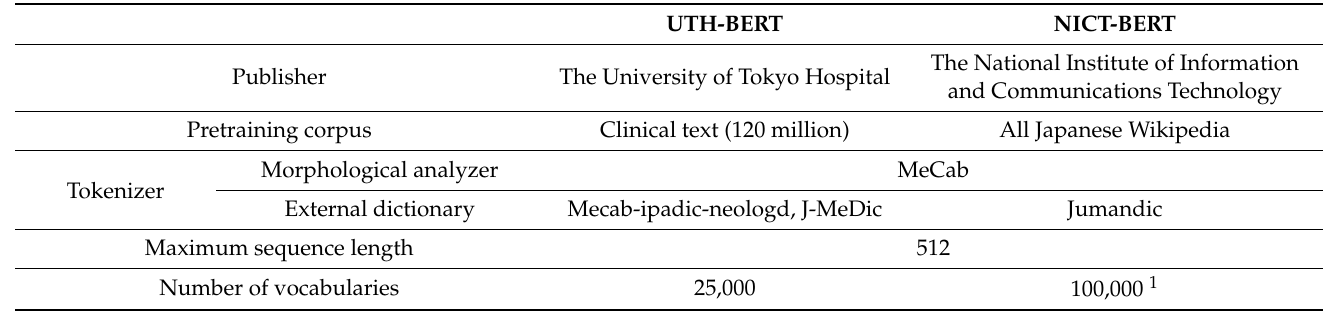
Table 1. The specifications of the pretrained BERT